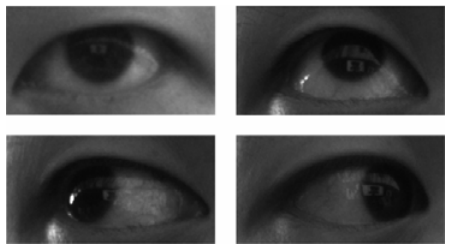
Figure 1: Four states of iris within the eye region.